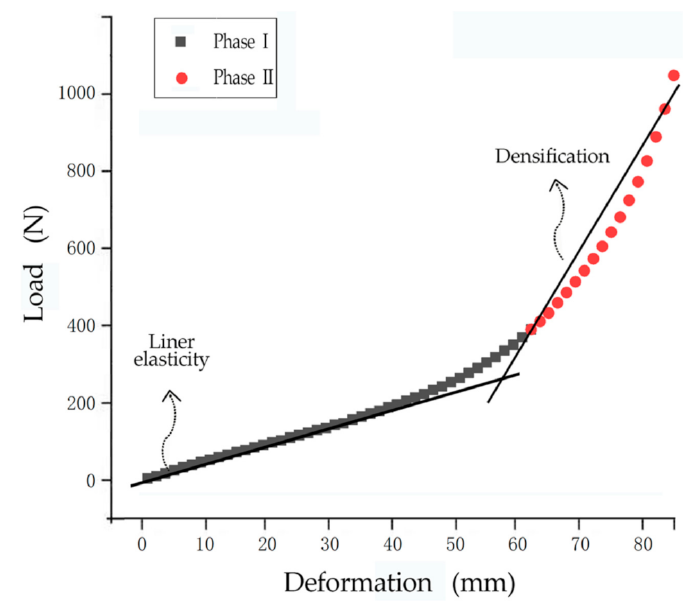
Figure 5. A typical load-deformation curve of the tested PLON block.